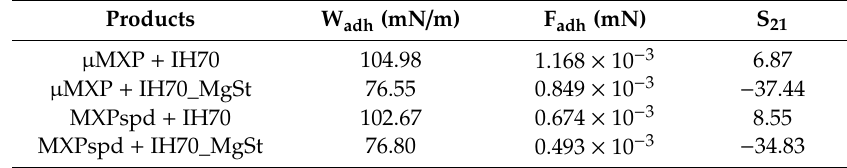
Table 4. The work of adhesion, adhesion, and spread coe ffi cient in the case of the carrier-based samples.